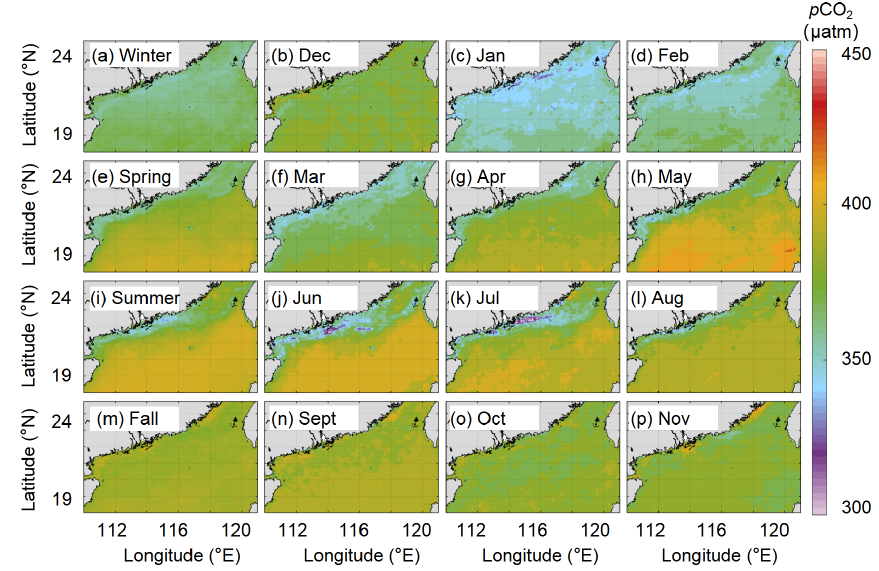
Figure 13. Long-term (2003–2020) seasonal and monthly averaged p CO 2 field in the region north of 18 ◦ N (µatm). (a) Winter. (b) December. (c) January. (d) February. (e) Spring. (f) March. (g) April. (h) May. (i) Summer. (j) June. (k) July. (l) August. (m) Fall. (n) September. (o) October. (p) November.